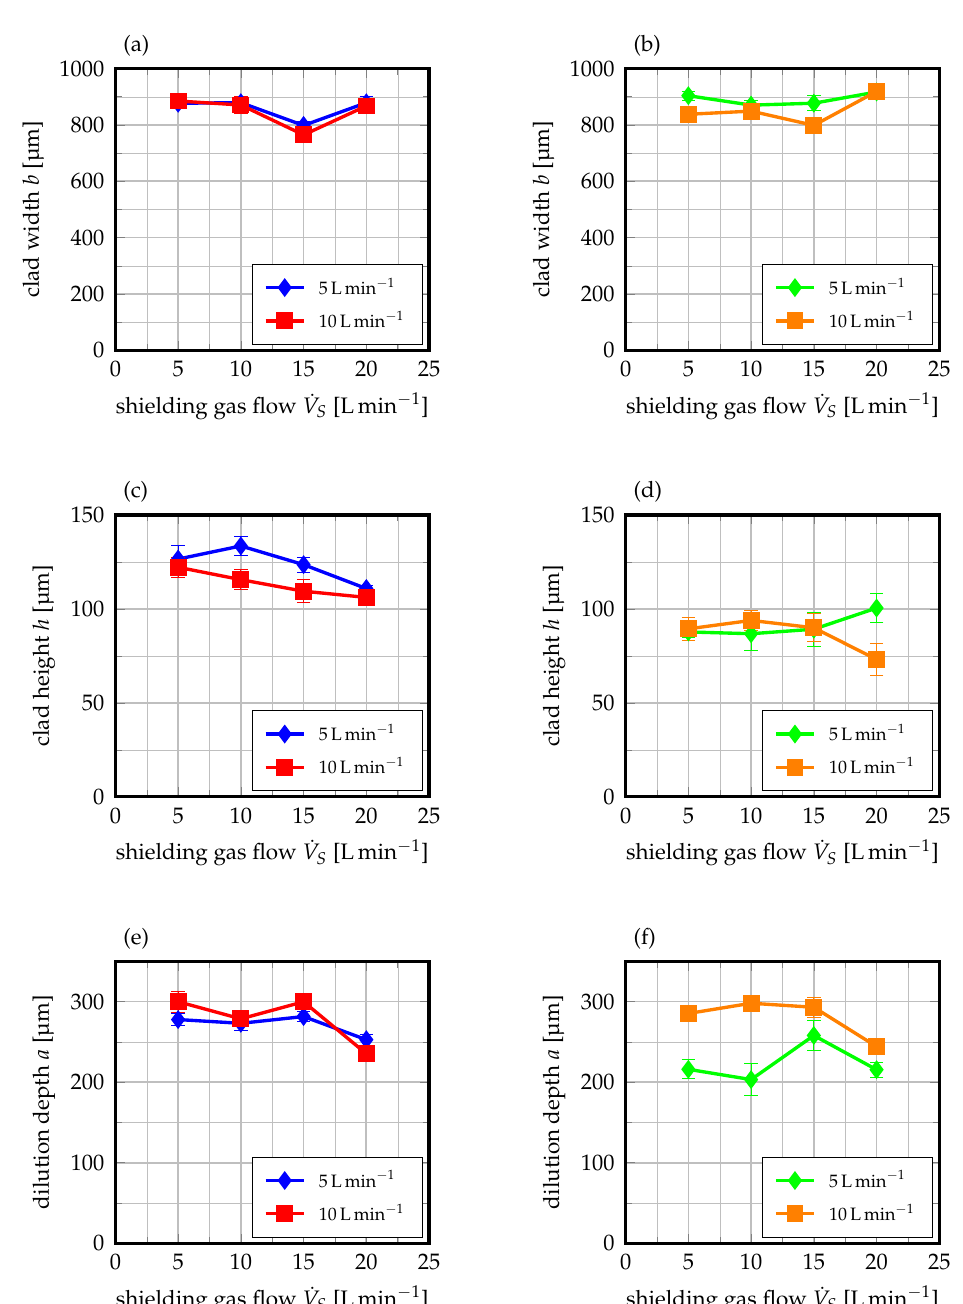
Figure 4. Target values of clad width b , clad heigth h , and dilution depth a for varying shielding gas flow rates ˙ V S and two constant carrier gas flow rates ˙ V P . Mean values of five measurements, with SEM. ( a , c , e ): 20–53µm, ( b , d , f ):